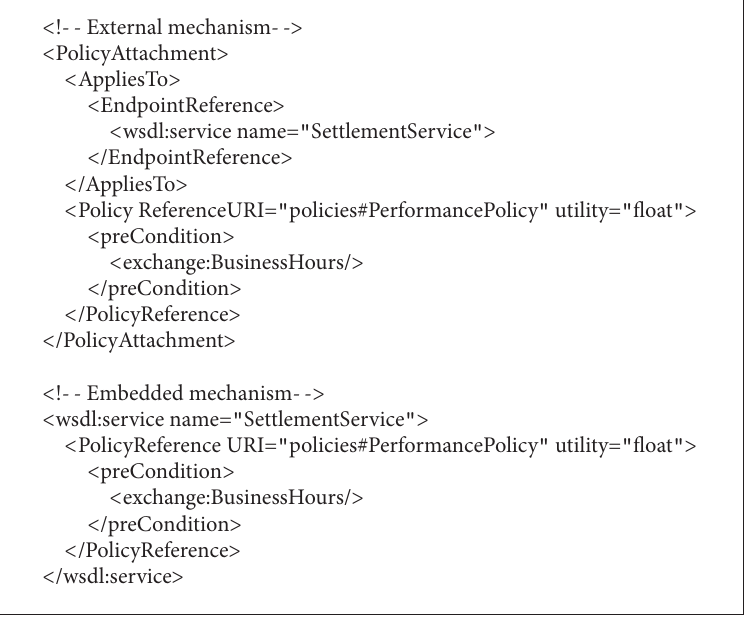
Algorithm 3: Policy attachment